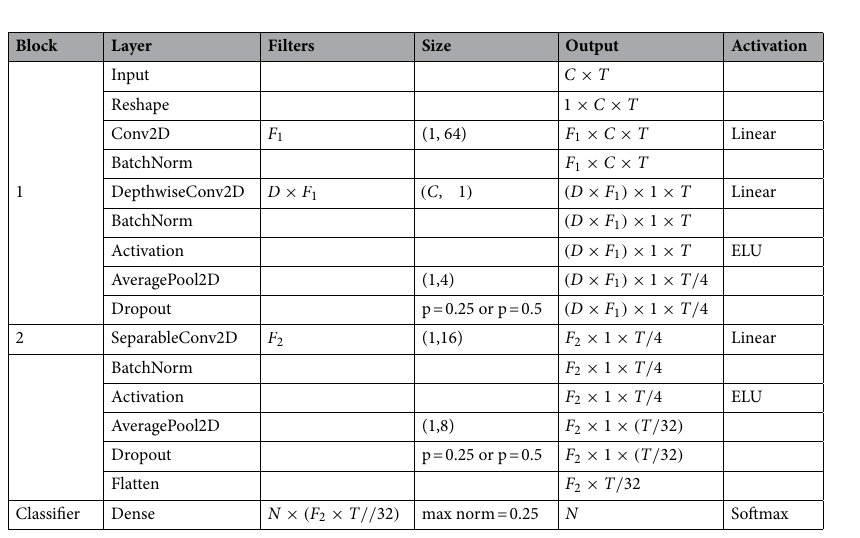
Table 1. Parameter setting of EEGNet structure, F 1 = number of temporal filters, D = depth multiplier, F 2 = number of pointwise filters.